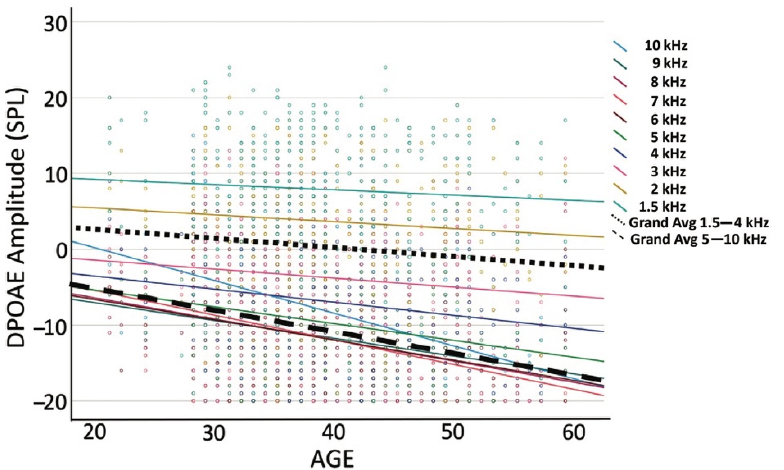
Figure 3. DPOAE amplitudes by age of the firefighters. The scatter plot shows DPOAE amplitude from all firefighters where age was reported, totaling 328 ears colored by frequency (f 2 ). The grand averages of DPOAE amplitudes for f 2 between 1.5 kHz and 4 kHz and f 2 between 5 kHz and 10 kHz are highlighted with two thick black dashed lines.